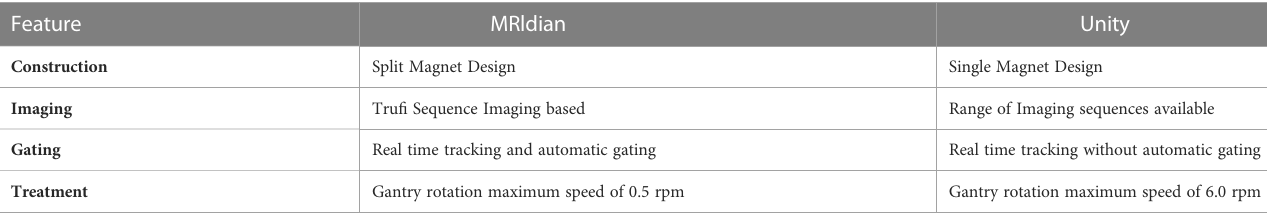
TABLE 2 Comparison of the MRIdian and Unity MRI-Linac radiotherapy platforms. Feature